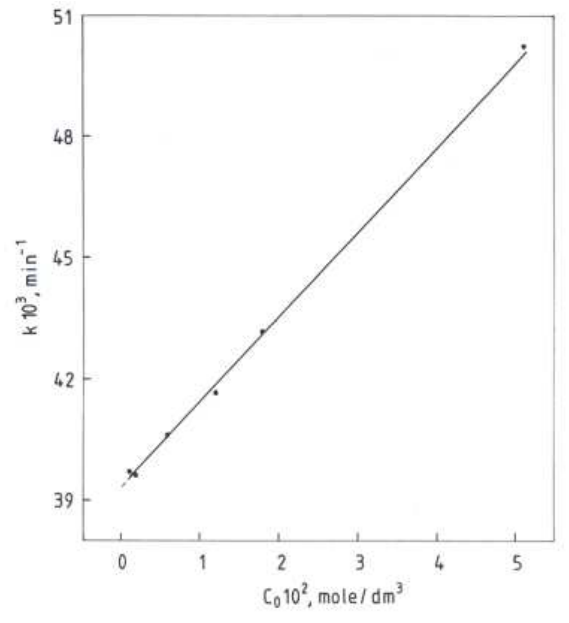
Fig. 6 The k values versus c 0 (given by Eq. (9)) for the adsorption of stearic acid at the benzene/water interface.